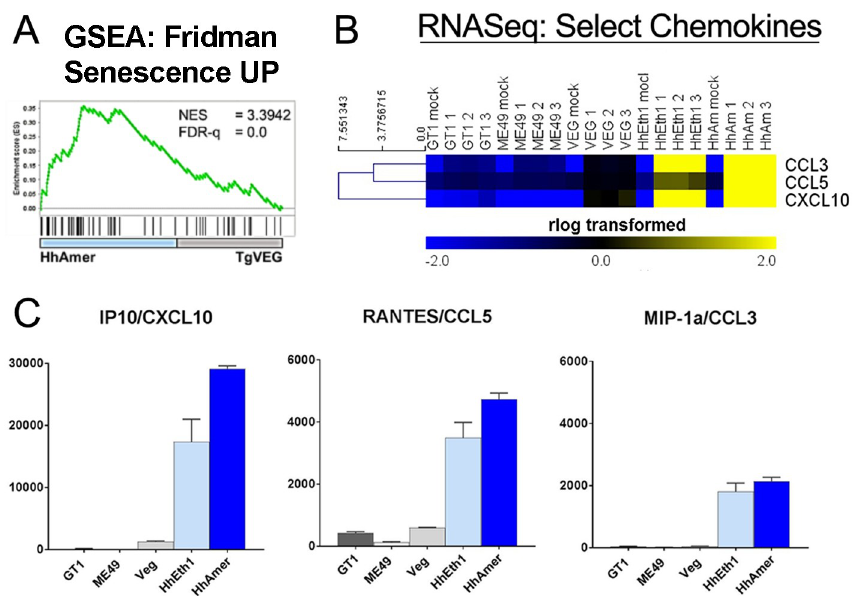
Fig 6. H . hammondi -infected cells have significantly enriched expression for genes involved in cellular senescence and the senescence-associated secretory phenotype (SASP). (A) GSEA of the Fridman Senescence Up gene set in T . gondii (TgVEG-) and H . hammondi (HhAmer)-infected THP-1 cells. HhAmer-infected cells were enriched in the Fridman Senescence Up gene set with a normalized enrichment score (NES) of 3.4. (B) Heatmap shows mean-centered hierarchically clustered (Euclidean distance) rlog -transformed values of transcript abundance for select chemokines and cytokines. (C) Supernatants from THP-1 cells infected with T . gondii or H . hammondi were collected 24 h post- infection and analyzed for pro-inflammatory cytokine secretion using the human cytokine 30-plex Luminex kit. Bars show relative changes in fluorescence intensity (fl) in parasite infected cells compared to mock-infected cells (fl infected–fl mock). Proinflammatory cytokines associated with the SASP that were of significantly different abundance between T . gondii and H . hammondi -infected THP-1 cells are shown (ANOVA followed by Tukey’s multiple comparisons test, p < 0.05). Error bars represent SEM of the change in fluorescence units over mock.